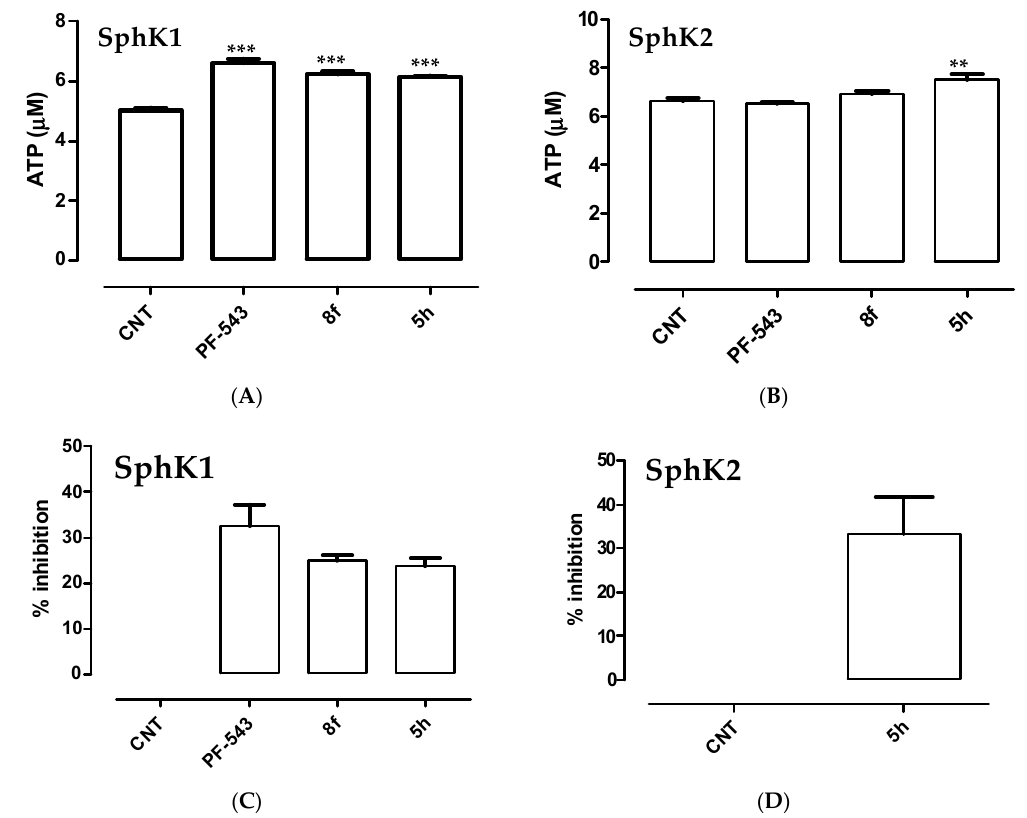
Figure 2. Effect of the tested compounds on the adenosine triphosphate (ATP) levels in the presence of SphK1 and SphK2. ( A , B ): ATP concentrations (µM) were measured by the Sphingosine Kinase Activity Assay (Echelon Biosciences) in the presence of SphK1 ( A ) and SphK2 ( B ), and tested with PF-543, 5h , and 8f . All the compounds were evaluated at the concentrations of 10 µM. For further details, see the Materials and Methods section. Data represent the mean (±SD) of two experiments performed in triplicate. Bars show SDs. ( C , D ): Percent of enzyme inhibition by PF-543, 5h , and 8f on SphK1 ( C ) and by 5h on SphK2 ( D ), respectively, as measured by the Sphingosine Kinase Activity Assay ( Echelon Biosciences).